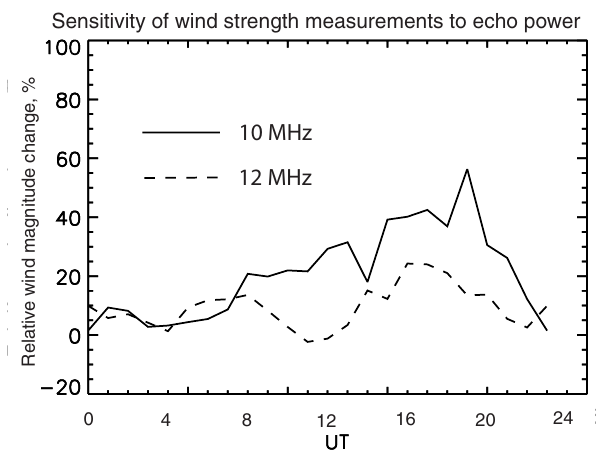
Fig. 8. Change in SuperDARN Doppler meteor wind magnitude between high power echoes ( > 20dB above noise) and all echoes, expressed as a percentage of the wind magnitude for all echoes over a diurnal cycle for 10 and 12MHz. The lines are average values for the first six range gates of the common programme.